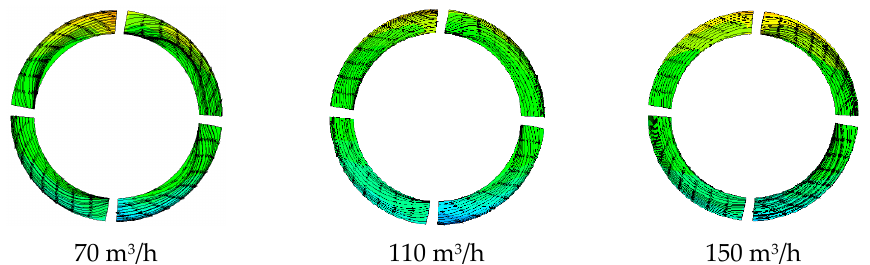
Figure 14. The streamline distribution of the middle section of the outlet section of the first impeller wheel.